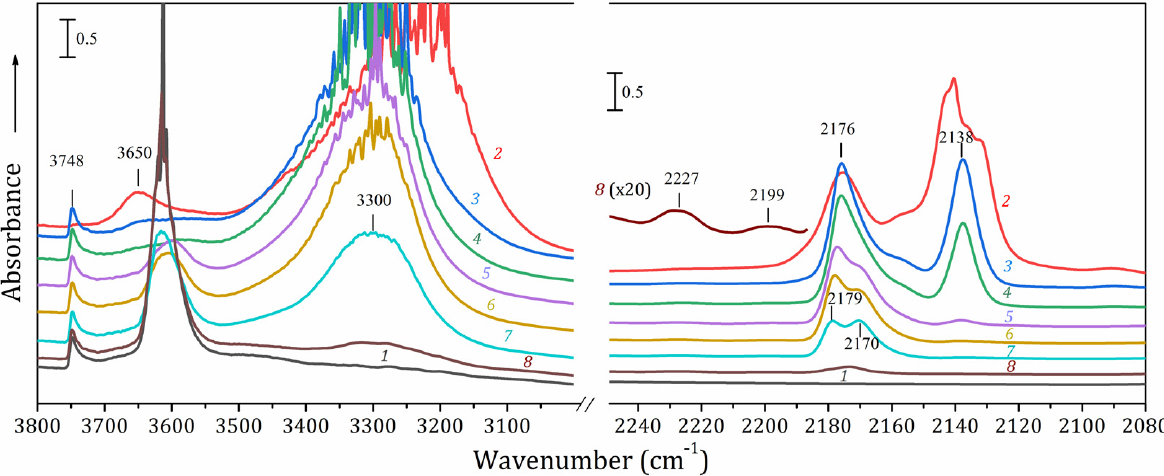
Figure 9. FTIR spectrum of CO adsorbed on H-MOR-19.8 pretreated at 450 ◦ C before ( 1 ) and after adsorption of CO ( 2 ), and on gradual desorption ( 3 – 8 ). Spectra are registered at − 196 ◦ C in the presence of ca 0.5 torr of helium.